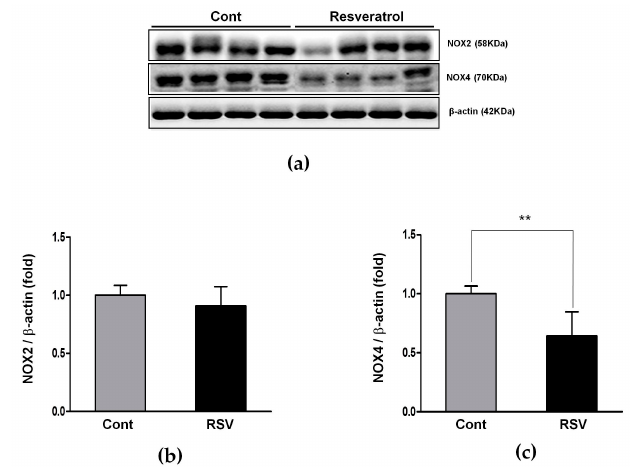
Figure 9. Effects of resveratrol on NOX2 and NOX4. ( a ) Representative western blots of NOX2 and